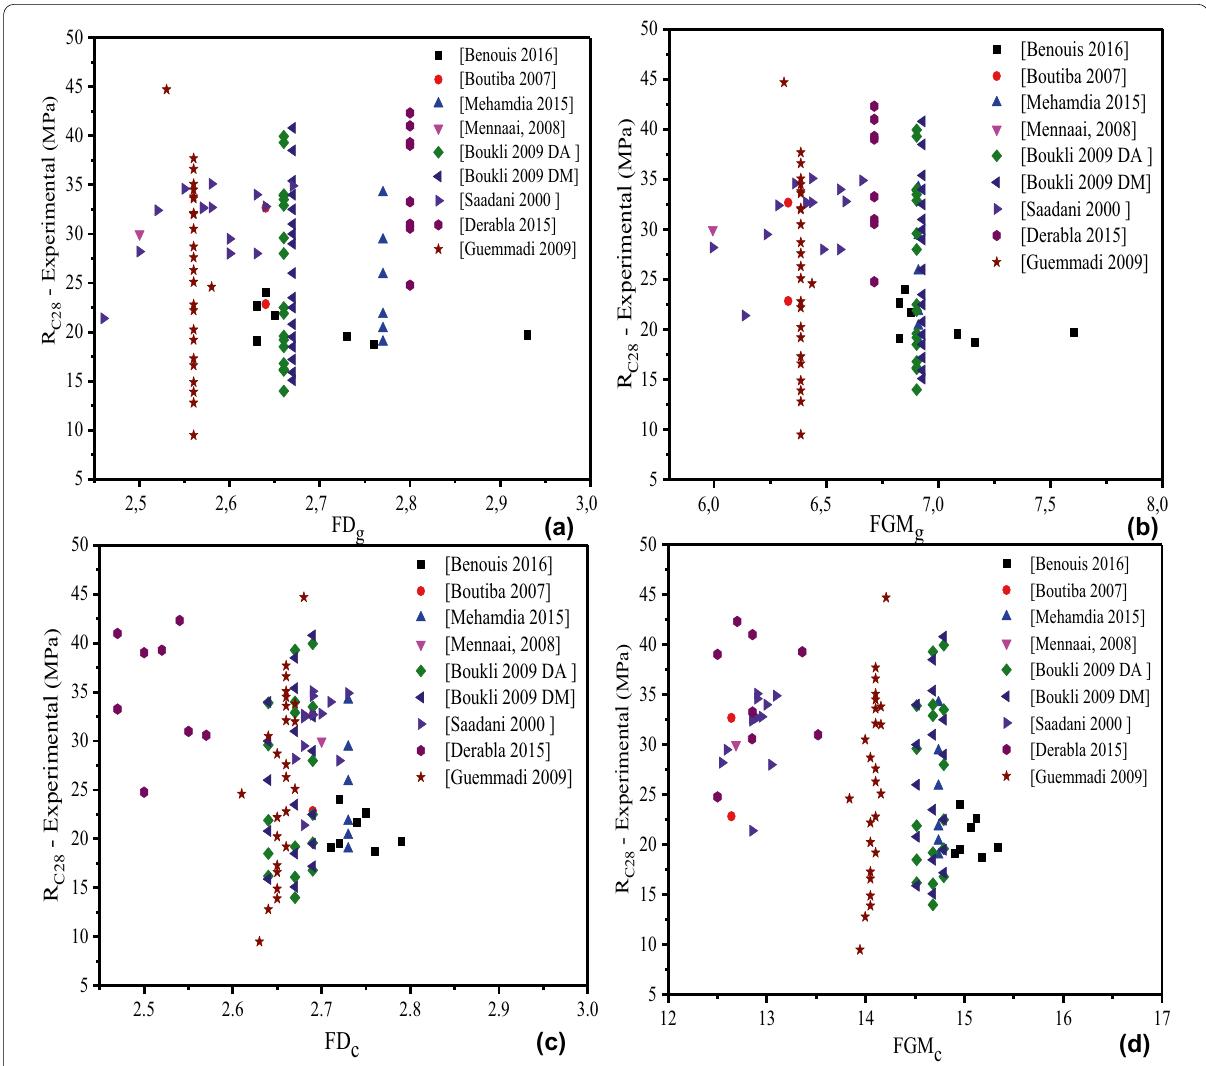
Fig. 10 Effect of the models FD g ,FGM g and FD C ,FGM c on the R C28 of concretes (all collected data). a Effect of fractal dimension FD g of basic granular mixtures, b Effec of fractal model FGM g of basic granular mixtures, c Effect of fractal dimension FD c of the granular mix of concrete, d Effect of the fractal model FGM c of the granular mix of